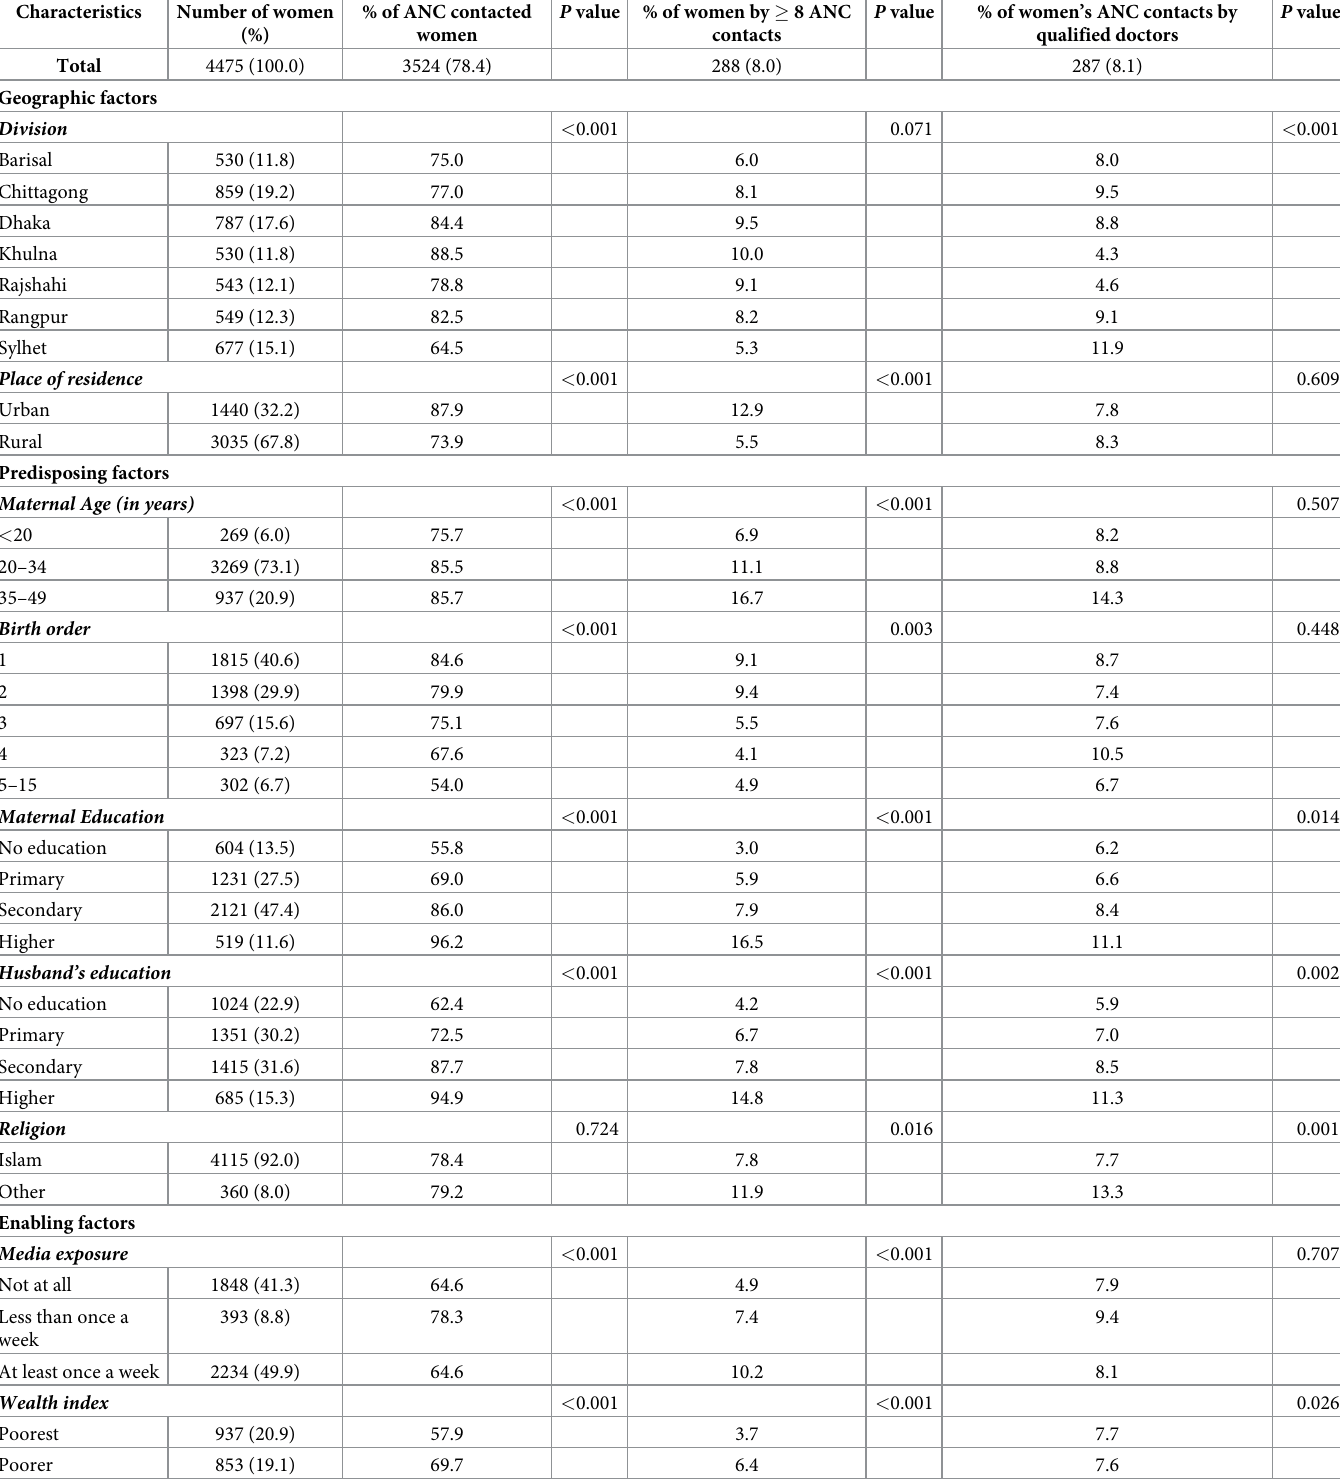
Table 1. Characteristics of the women, percentage of women by ANC contacts, percentage of women by the WHO recommended ANC contacts and percentage of women’s ANC contacts by skilled doctors.